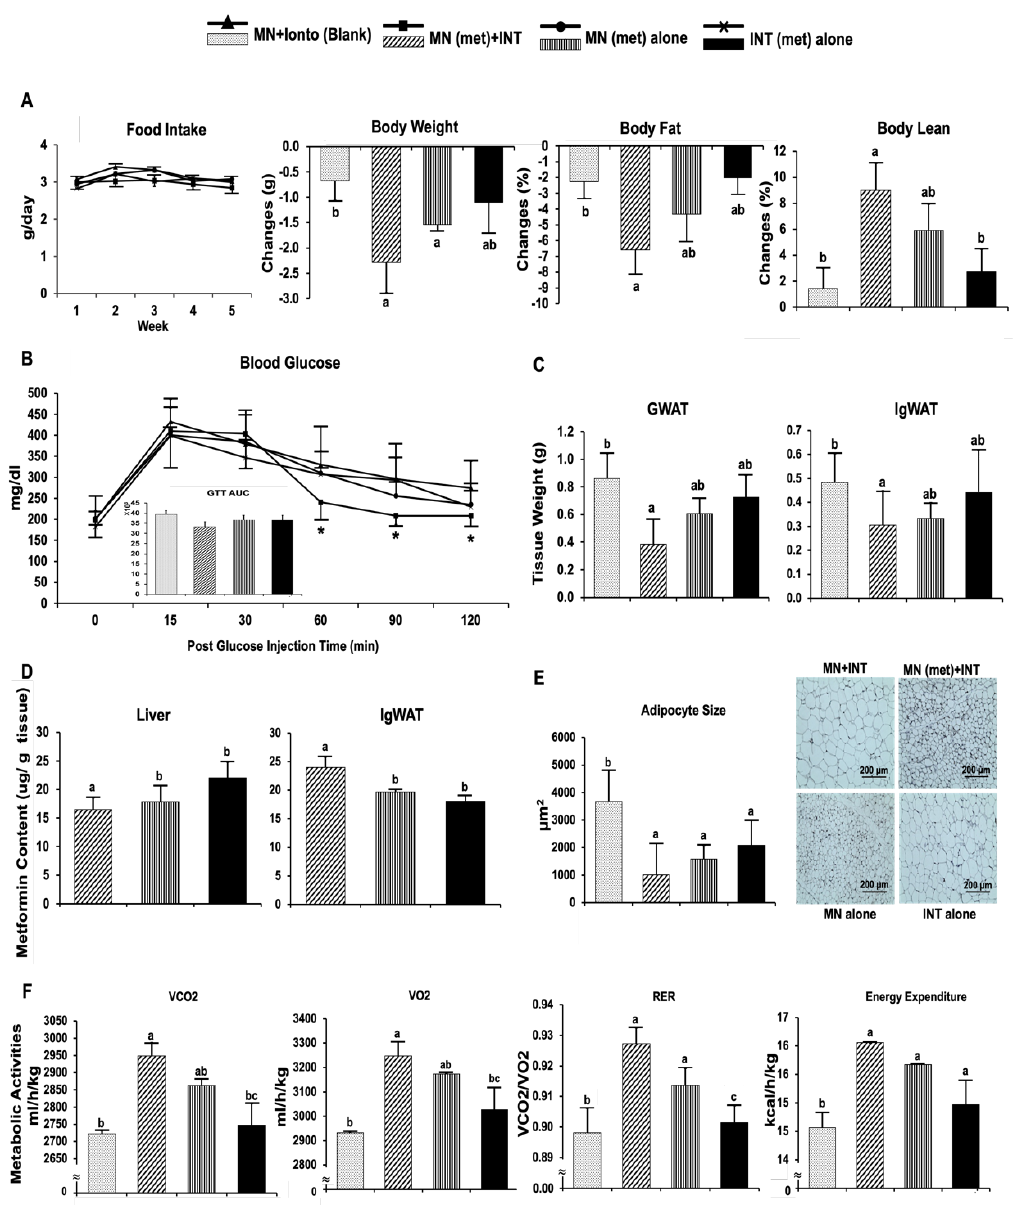
Figure 3. Anti-obesity and metabolic effects of metformin. ( A ) Food intake, body weight, fat %, and lean %; ( B ) blood glucose levels and glucose tolerance test area under the curve; ( C ) tissue weight of GWAT and IgWAT; ( D ) metformin content in the liver and IgWAT; ( E ) adipocyte size; ( F ) metabolic activity parameters. (*) Lower blood glucose. Values are means ± SEM, n = 5 per treatment. Bars without a common superscript differ at p < 0.05.